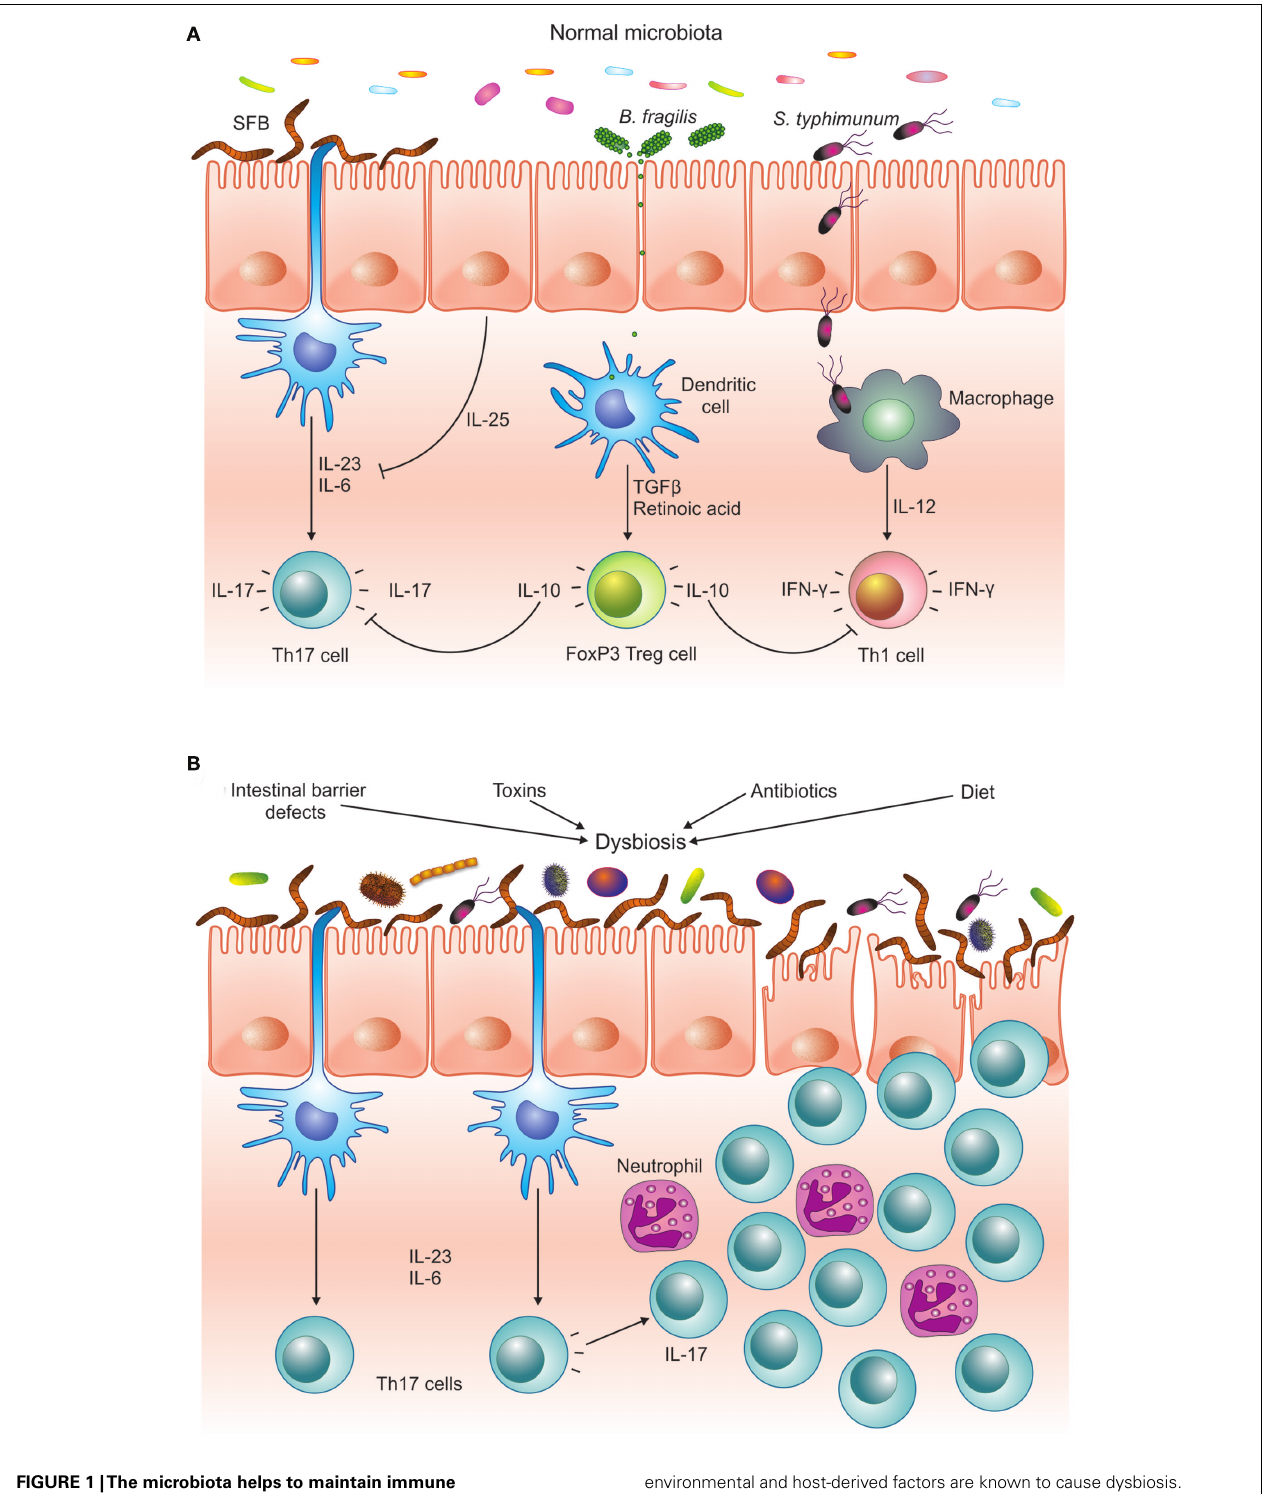
FIGURE 1 |The microbiota helps to maintain immune homeostasis by stimulating different arms of theT cell response. (A) SFB is a potent inducer ofTh17 cells, whereas pathogens like S. typhimurium induce an effectorTh1 response. PSA from B. fragilis stimulates the differentiation of FoxP3 + T cells, which downregulate the pro-inflammatoryTh1 andTh17 responses. (B) Different